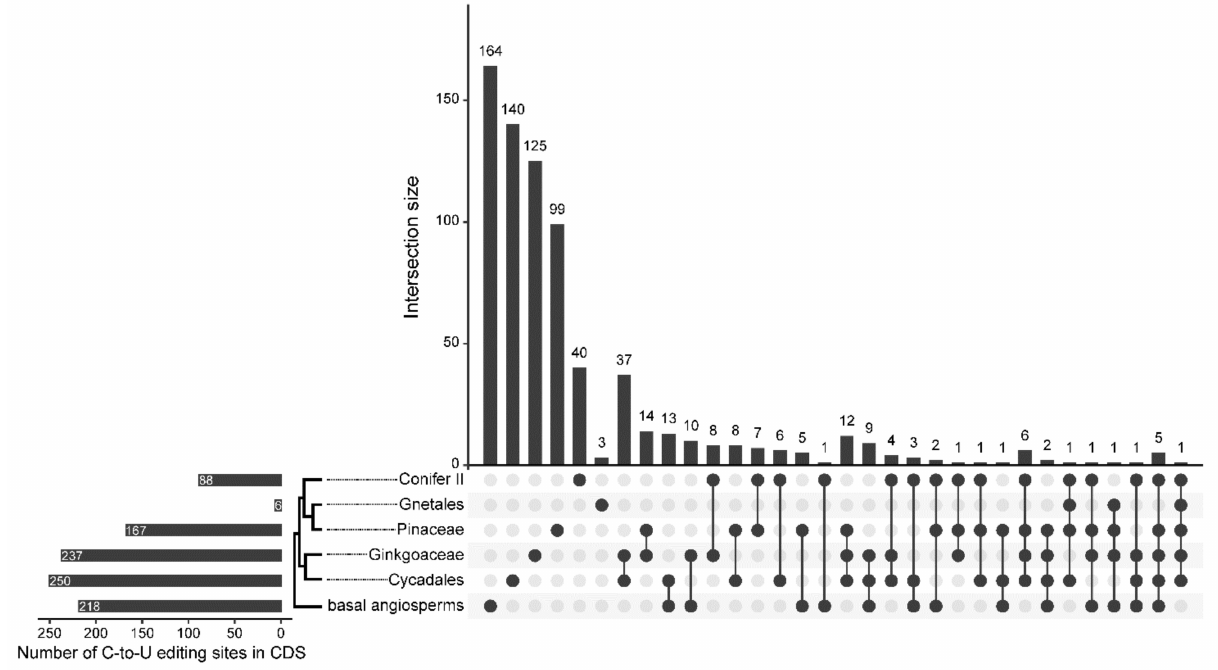
Figure 6. UpsetR plot illustrating the intersection of chloroplast C-to-U RNA editing sites of different gymnosperm lineages. The bottom-left bar plot shows the number of RNA editing sites in the